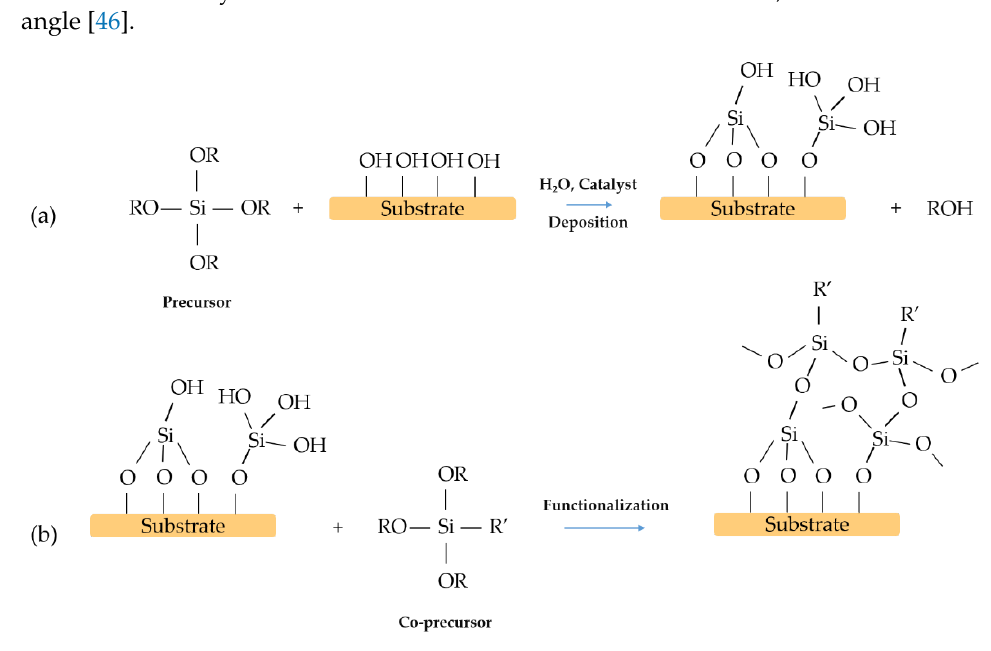
Table 1. One-pot syntheses of hydrophobic silica films.